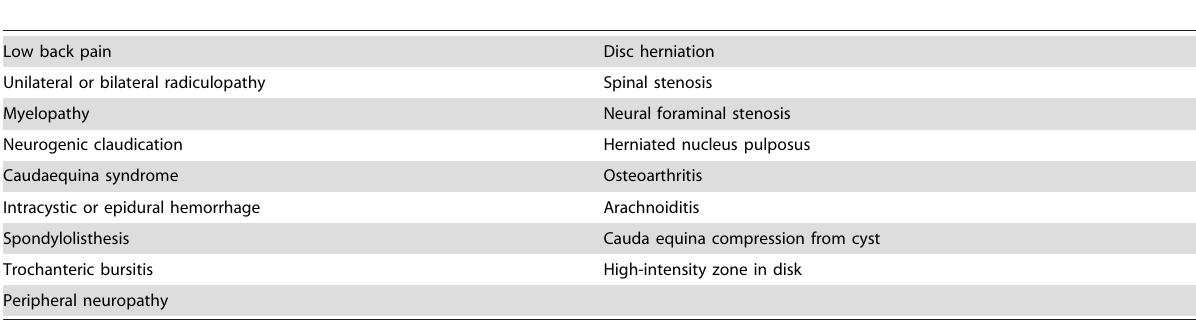
Table 3. Common presenting conditions of lumbar facet joint